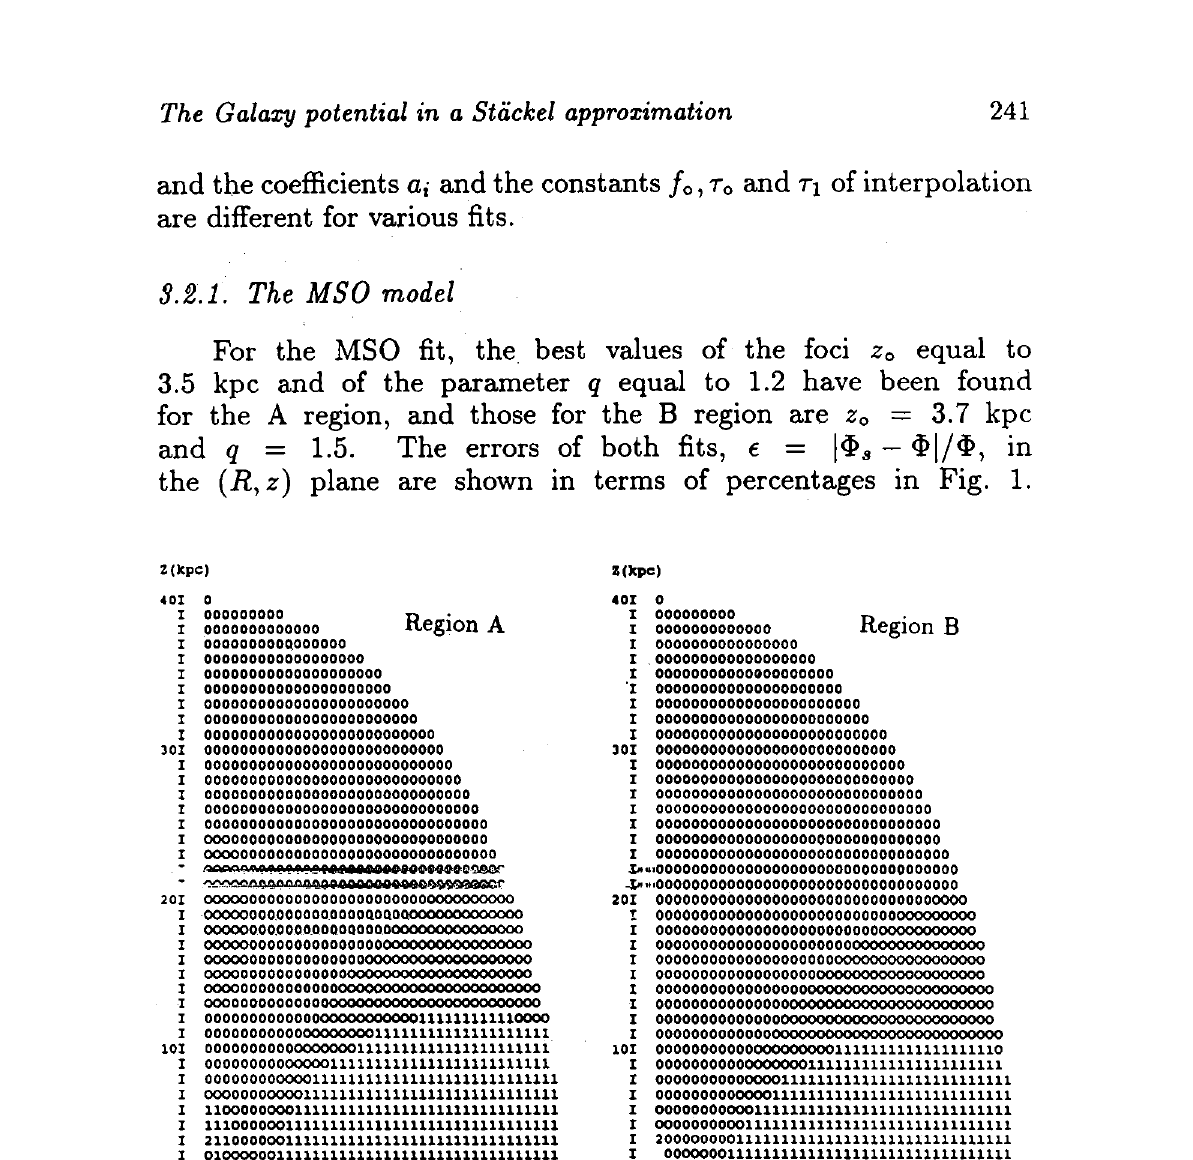
Fig. 1. The MSO fit in the ( R , z ) plane for the A region (z = 0 3.5 kpc, q = 1.2) and B region (z = 3.7 kpc, q = 1.5). Relative errors 0 of the fit, e = — are plotted in terms of percentages. The symbols denote: 0-e < 0.2 %, 0-e < 0.5 %, 1-e < 1.5 %, 2-e < 2.5 %, 3-e < 3.5 %, 5- e < 5.5 %, A-e < 10